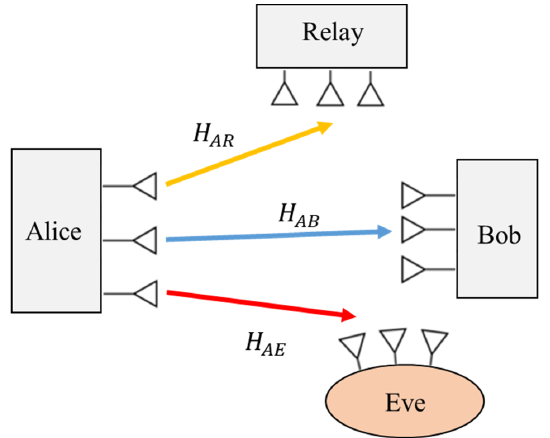
Figure 6. A system model for a wiretap relay channel in the first time slot.